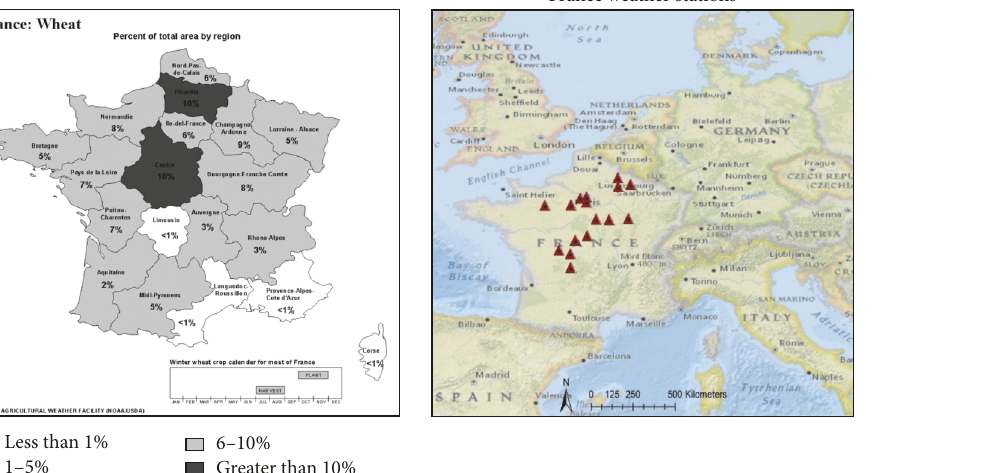
(a) France wheat production map. Source : USDA ERS, 2014